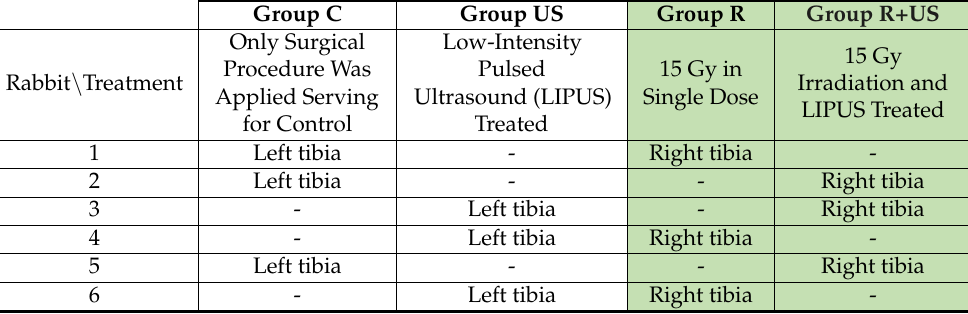
Table 2. Details on the four treatments randomly applied to the tibiae of six rabbits. Group C Rabbit \